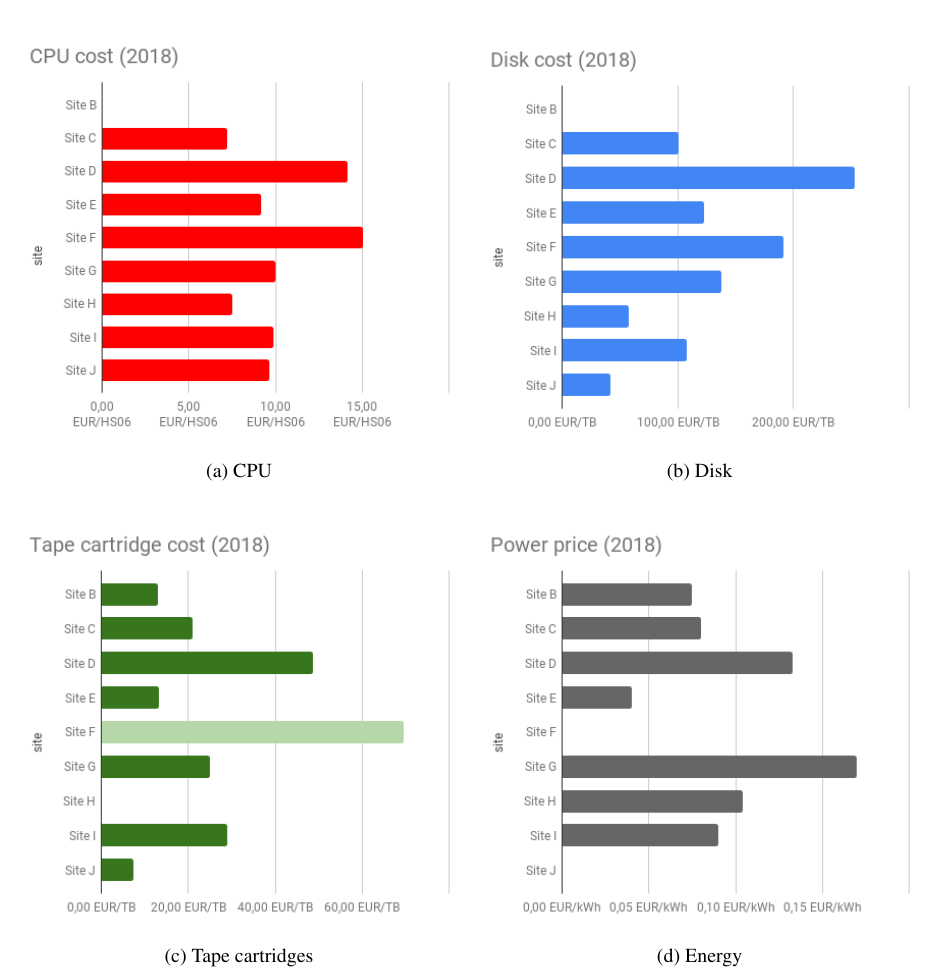
Figure 2. Distribution of IT resource and energy costs across various WLCG sites.